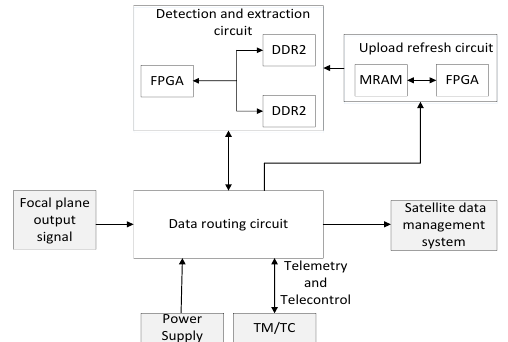
Figure 2. System schematic of instantaneous point source target